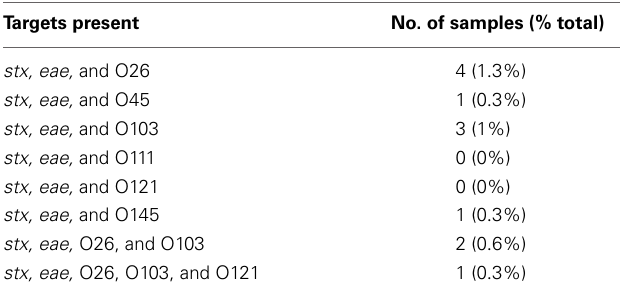
Table 4 | Salmonella serotypes isolated from the different ground beef samples and antibiotic resistance profiles of the isolates.